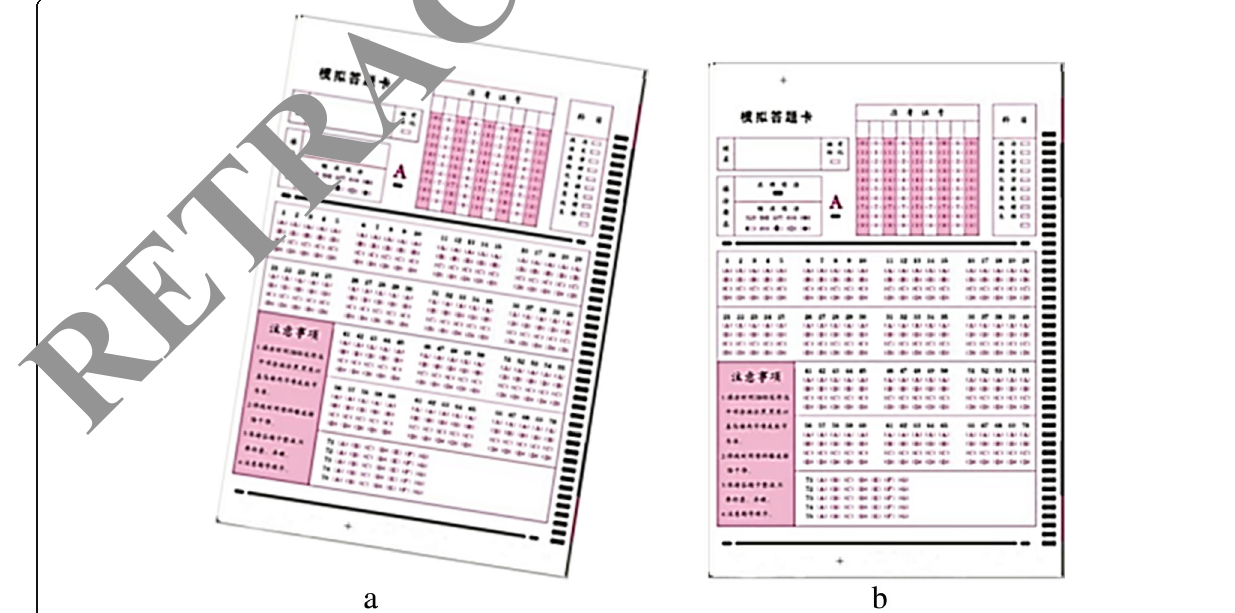
Fig. 5 Image detection results with a tilt angle of 9.36°. a Original oblique image b Corrected